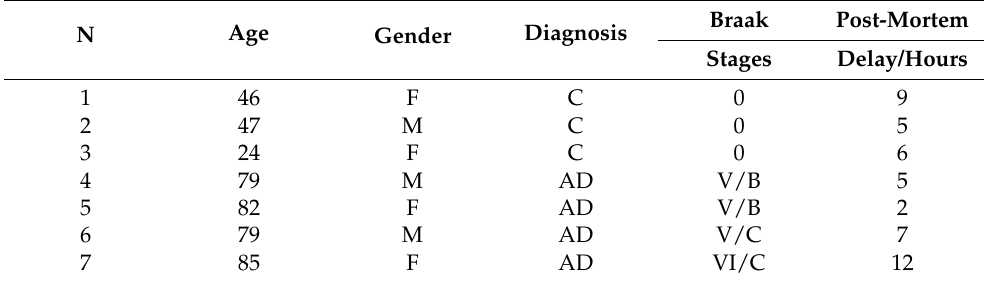
Table 1. Summary of the patients from whom hippocampal samples were obtained and studied. C: control, AD: Alzheimer’s disease; A, B and C: Braak and Braak’s classification of AD stages depending on amyloid plaques; 0-V: Braak and Braak’s classification of AD stages depending on the distribution and number of neurofibrillary tangles.